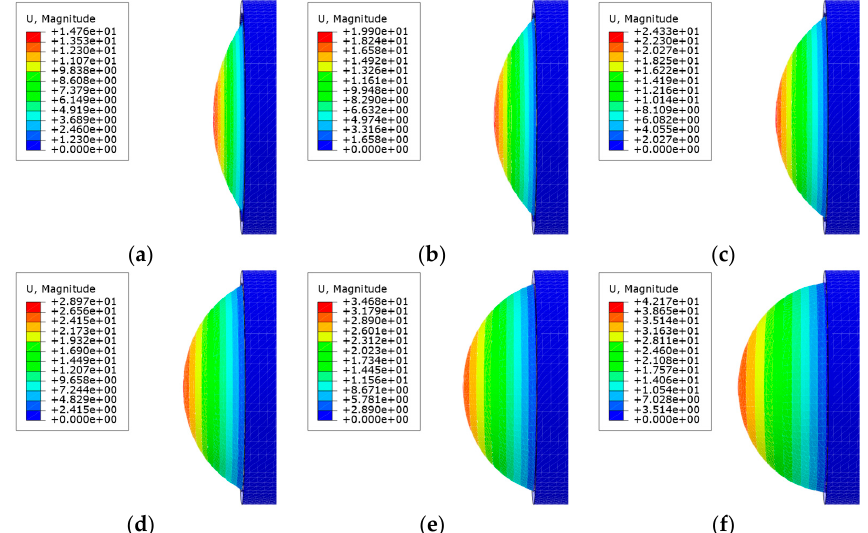
Figure 4. Based on the ABAQUS software, the model state renderings of the CTPM under different air pressures are simulated. ( a – f ) is the simulation effect diagram of CTPM from the relative ambient air pressure 6 kPa–36 kPa with a gradient of 6 kPa.